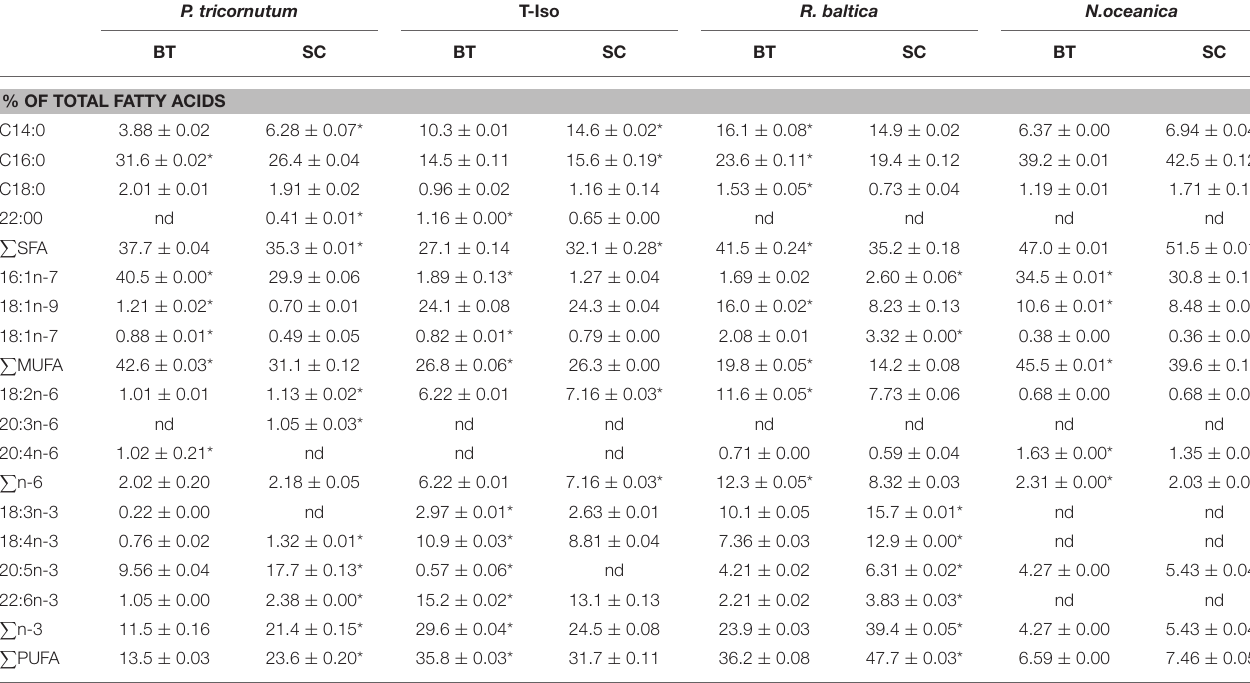
TABLE 2 | Fatty acid profiles (% of total fatty acids) of four microalgae species from batch and semi-continuous culture. P. tricornutum